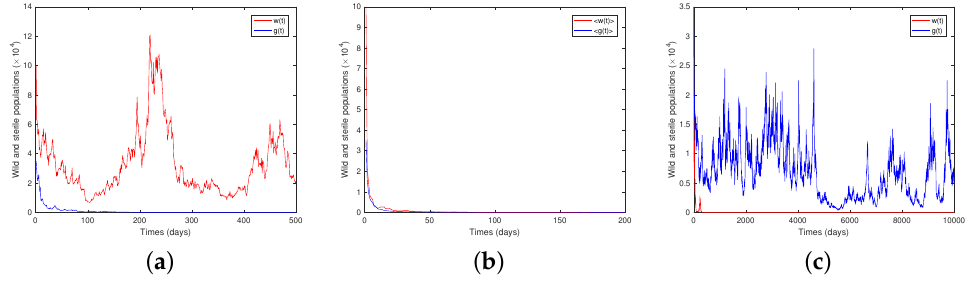
Figure 2. Solutions of Model (13) for a = 2, b = 0.9, µ 1 = ξ 1 = 0.5, µ 2 = ξ 2 = 0.4, g 0 = 3.5 with step size ∆ t = 0.001. ( a ) is for σ 1 = 1.2, σ 2 = 2; ( b ) is for σ 1 = 2, σ 2 = 1; ( c ) is for σ 1 = 2, σ 2 =